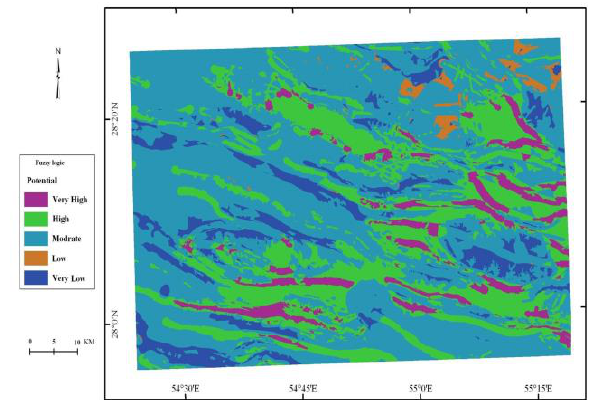
Figure 6. Groundwater potential map using fuzzy logic